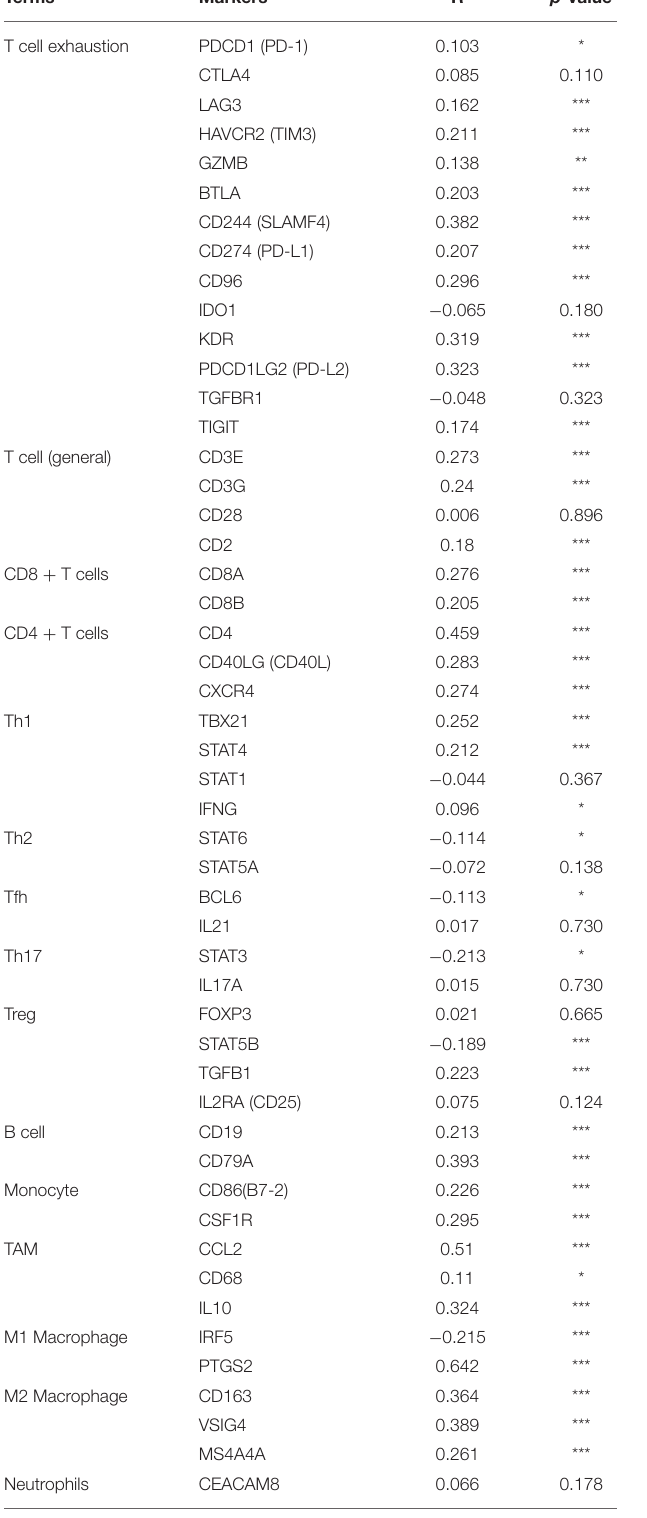
TABLE 4 | Spearman correlation analysis between NTF3 and markers of immune cells in HCC. Terms